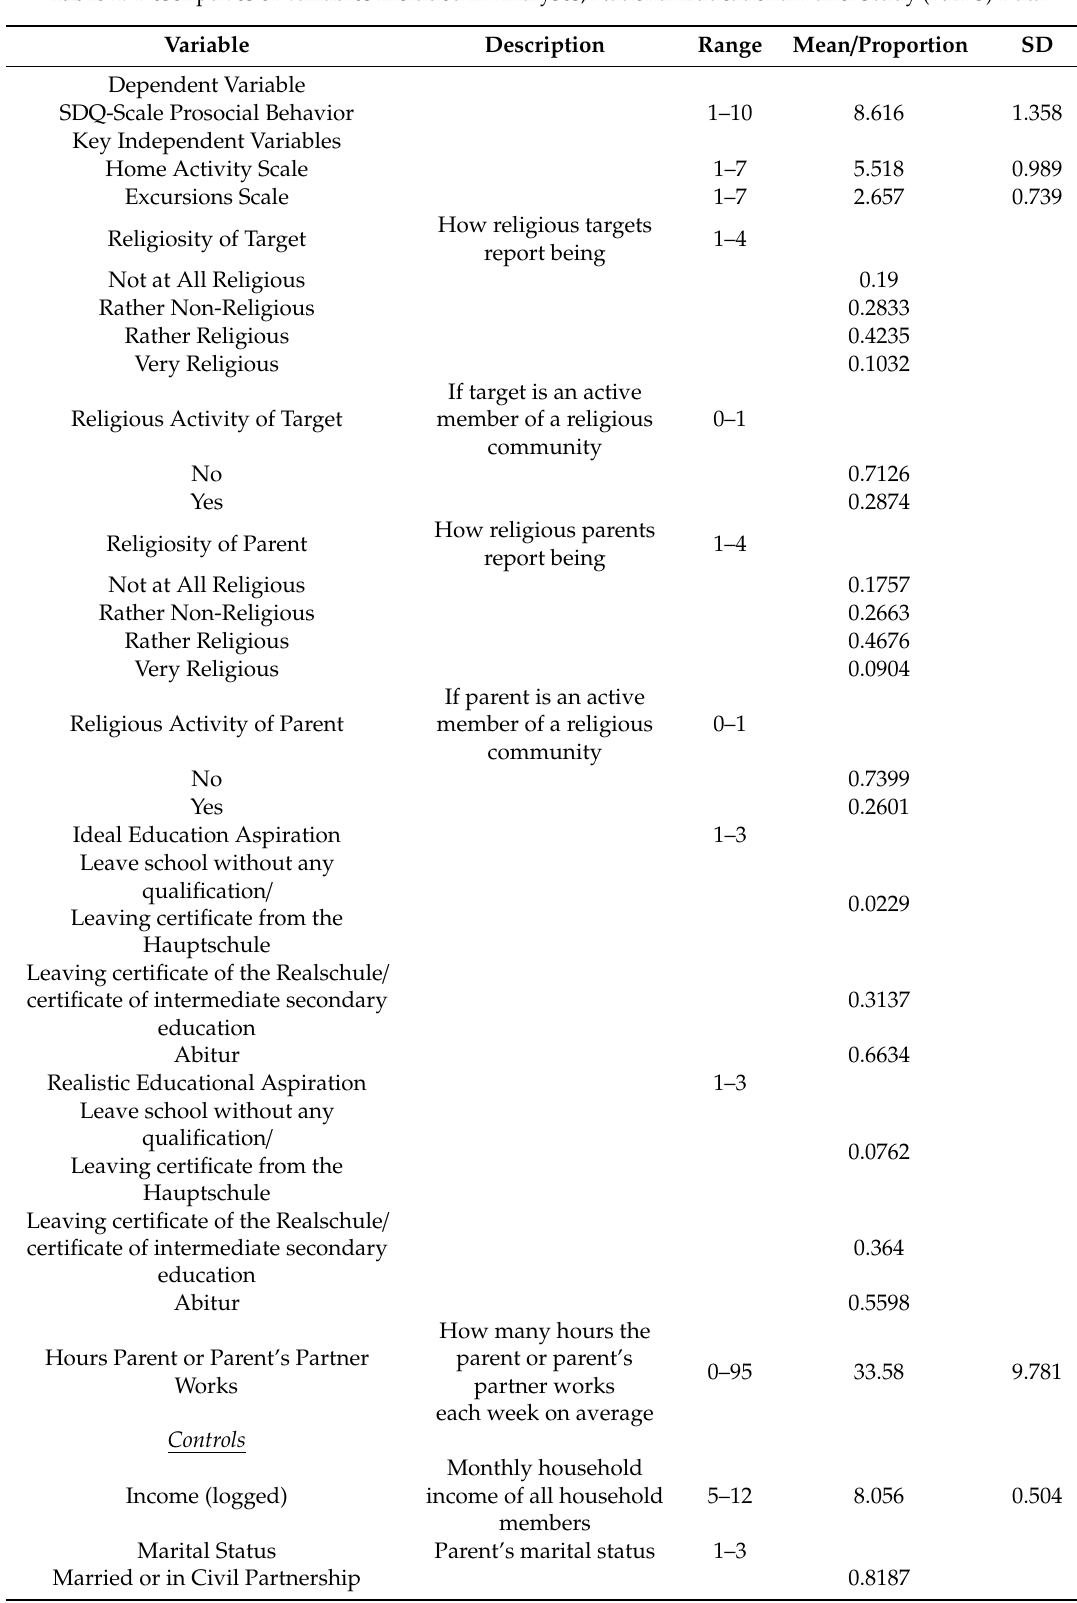
Table 1. Descriptives of Variables Included in Analyses, National Educational Panel Study (NEPS)